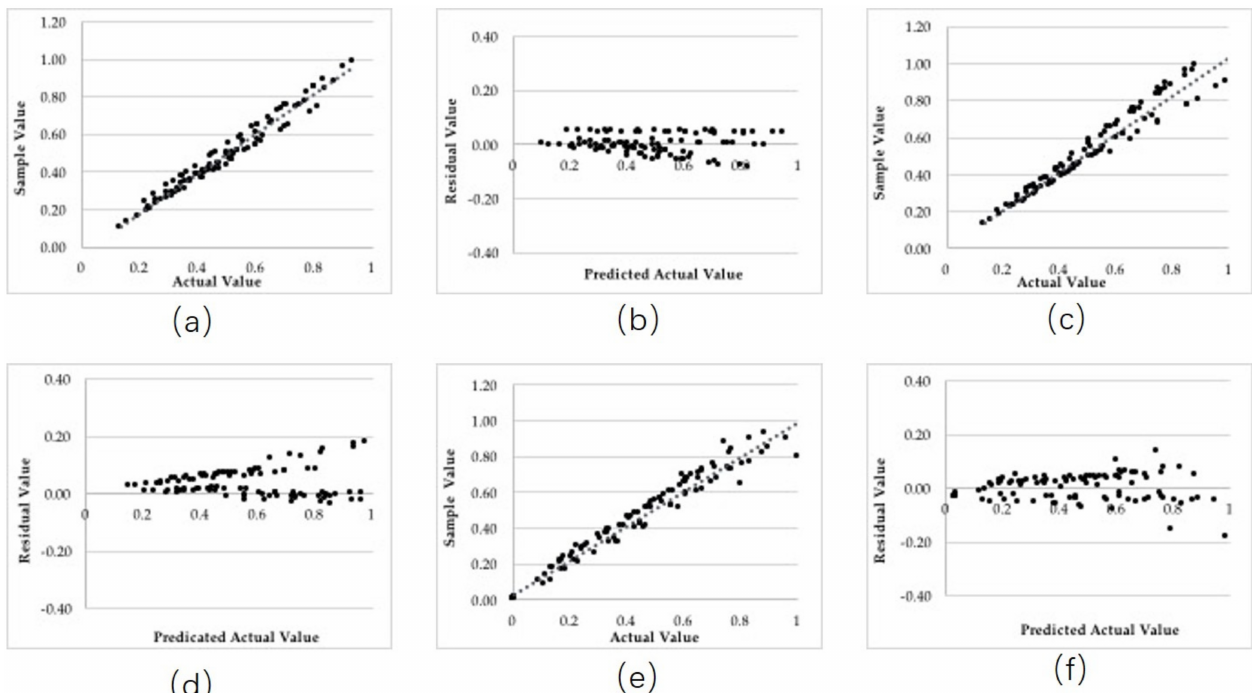
Figure 12. Regression results and residual results: ( a , b ) 1995; ( c , d ) 2005; ( e , f ) 2016.